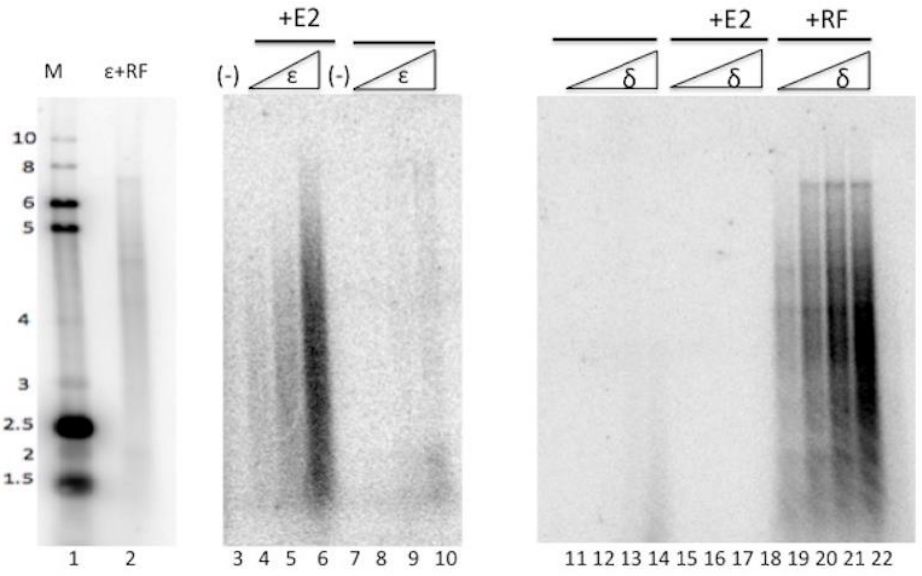
Figure 1. HPV E2 stimulates pol ε. Pol ε was added to primed M13 reactions containing 40 ng/μL of HPV 11 GST-E2 (lanes 2–4) or to reactions without E2 (lanes 6–8). Pol ε was added in amounts ranging from 1 ng/μL to 8 ng/μL (lanes 4–6 and 8–10). Pol δ was added in increasing amounts (1 ng/μL to 8